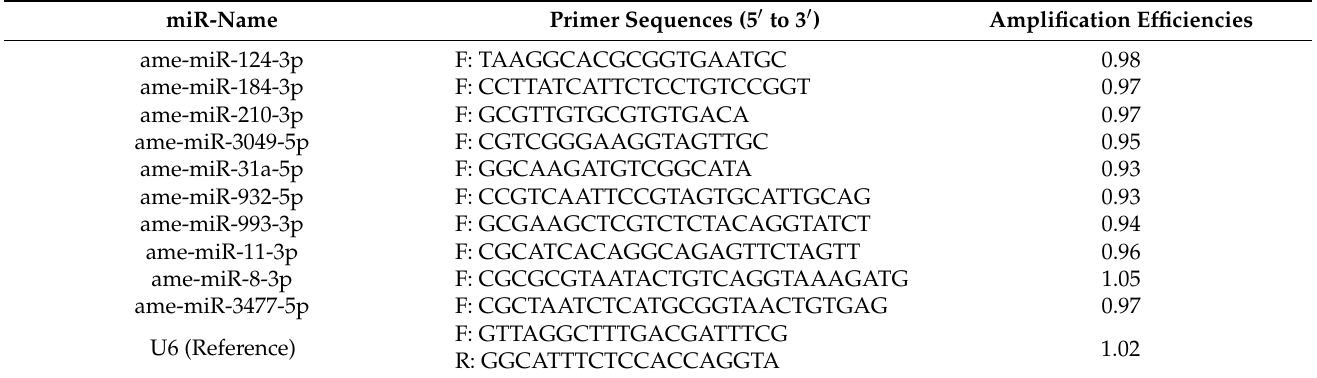
Table 1. Primers used in the present study.